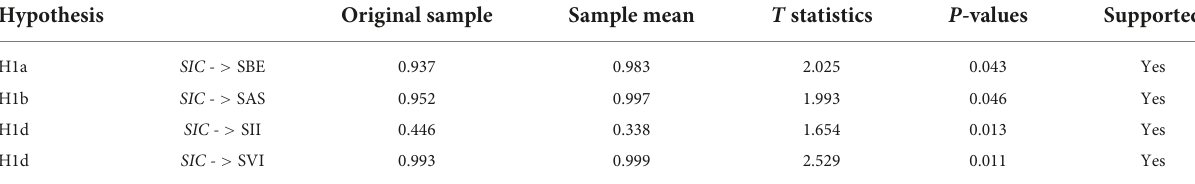
TABLE 8 Direct relationships.